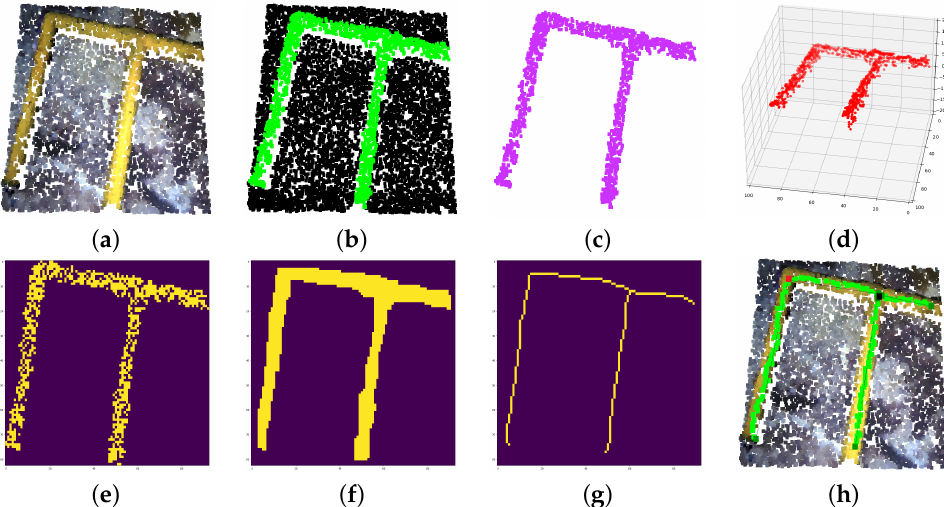
Figure 8. Pipe information extraction process. ( a ) Original point cloud. ( b ) Deep neural network segmentation. ( c ) Instance clustering. ( d ) 3D voxelization. ( e ) 2D matrix flattening. ( f ) Morphological operations: closing and opening. ( g ) Morphological operation: skeletonization. ( h ) Information reprojection overlapped onto original point cloud (light green: skeleton, dark green: pipe start-end, red: elbow, black: connection, lines: pipe